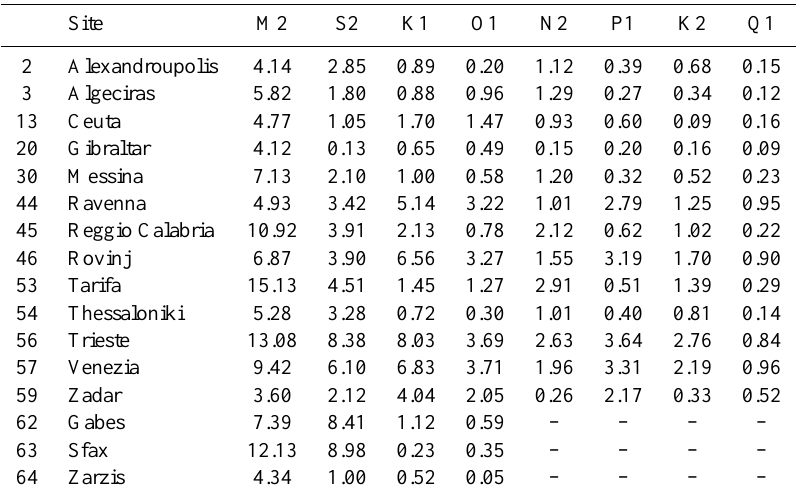
Table 4. Vectorial differences (formula 17) exceeding 4cm between observed constituents and TPXO7.2. The last three rows are related to data taken from Tsimplis et al. (1995). Unit